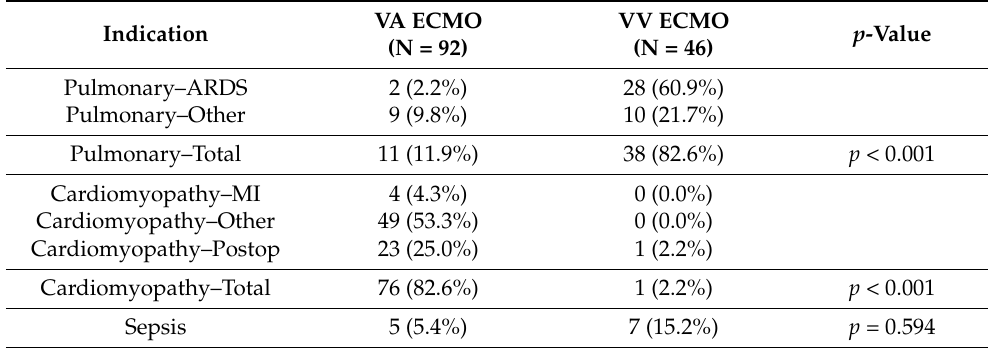
Table 2. Indications for VA and VV ECMO.